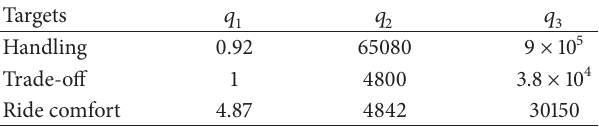
Table 6: Weightings for different control